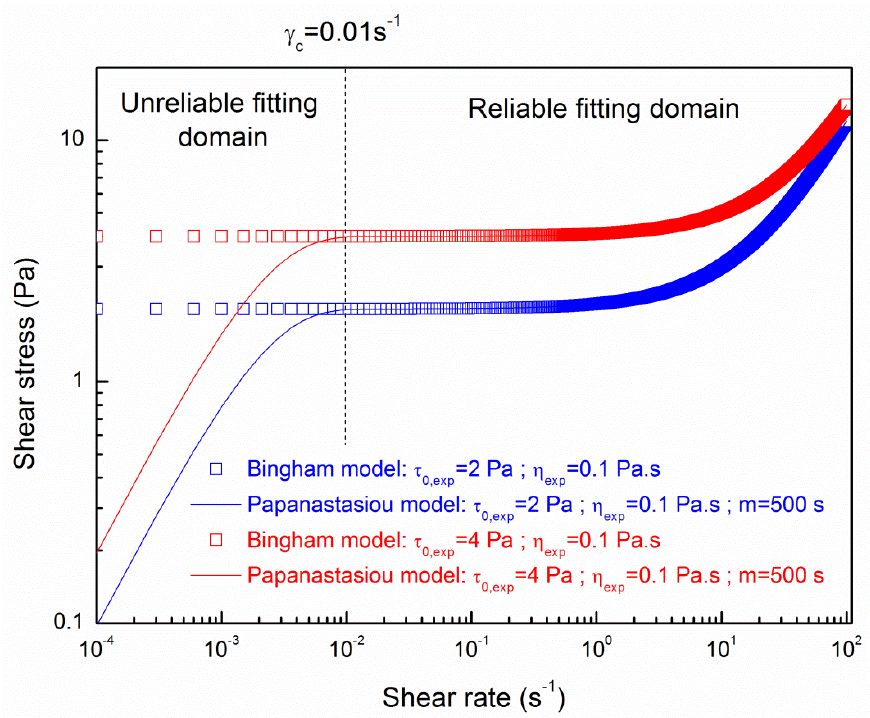
Figure 3. Rheological behaviour of the cement pastes modeled by the Bingham model from experimental measurements of Pierre et al. [27] approached with the Papanastasiou model.